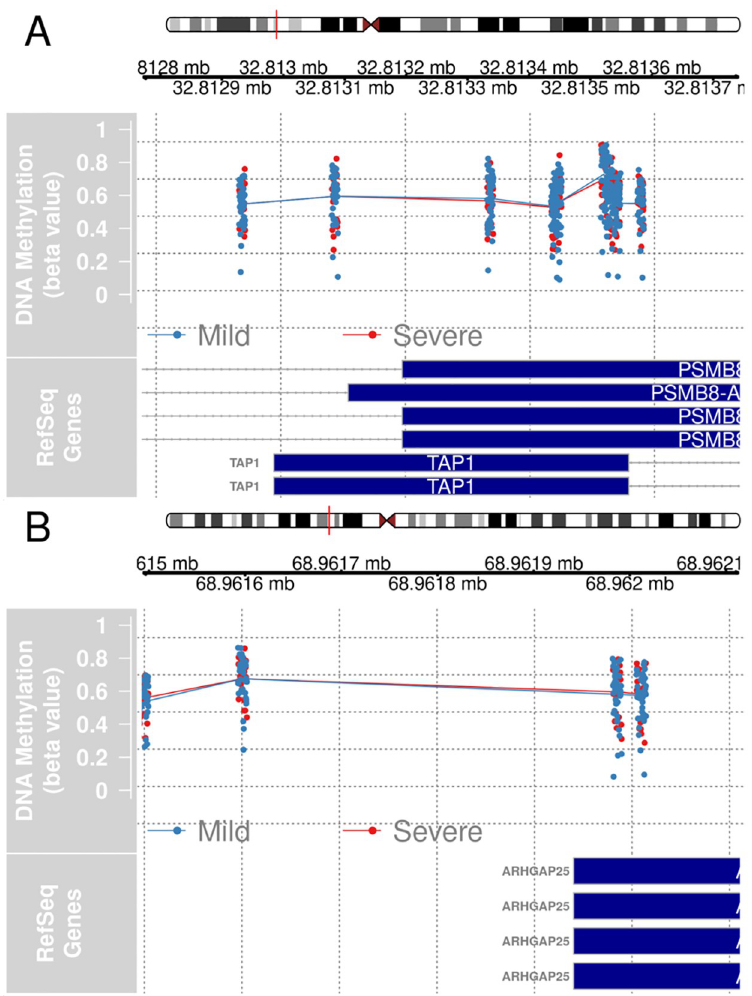
Fig 3. Statistically significant DMRs ( fwerArea � 0.05) between severe and mild SS cases located in genes previously identified as hypomethylated in cases relative to non-cases. (A) DMR located in PSMB8 and TAP1 , (B) DMR located in ARHGAP25